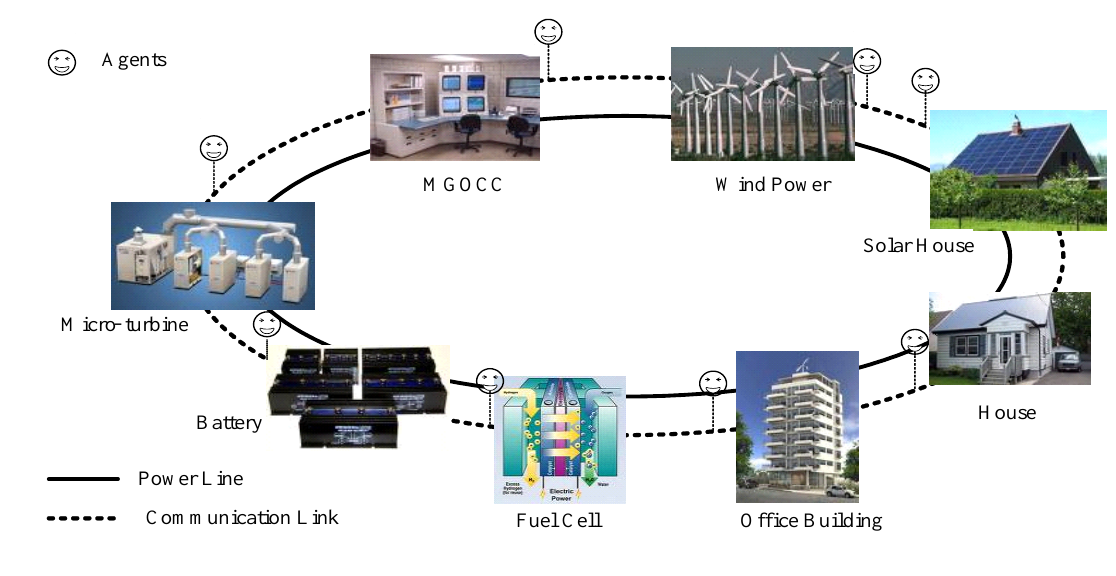
Table 1. Agent communication protocols.